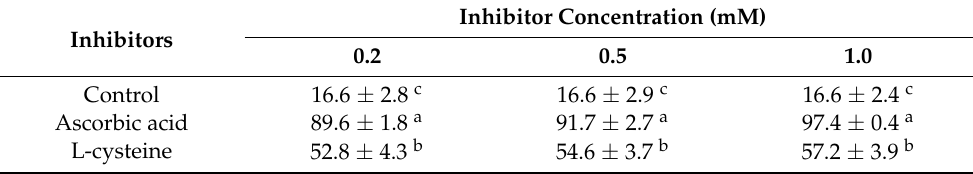
Table 1. Effects of the two main inhibitors on the activity of tocopherol oxidase (% tocopherol